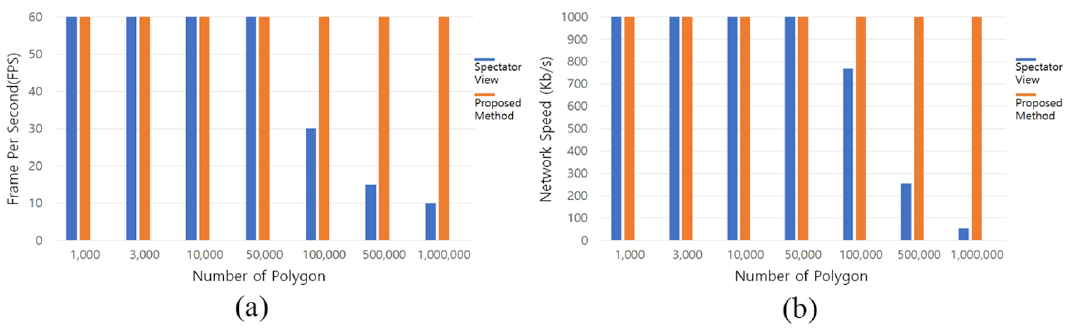
Figure 12. Performance comparison: ( a ) Spectator View; ( b ) proposed